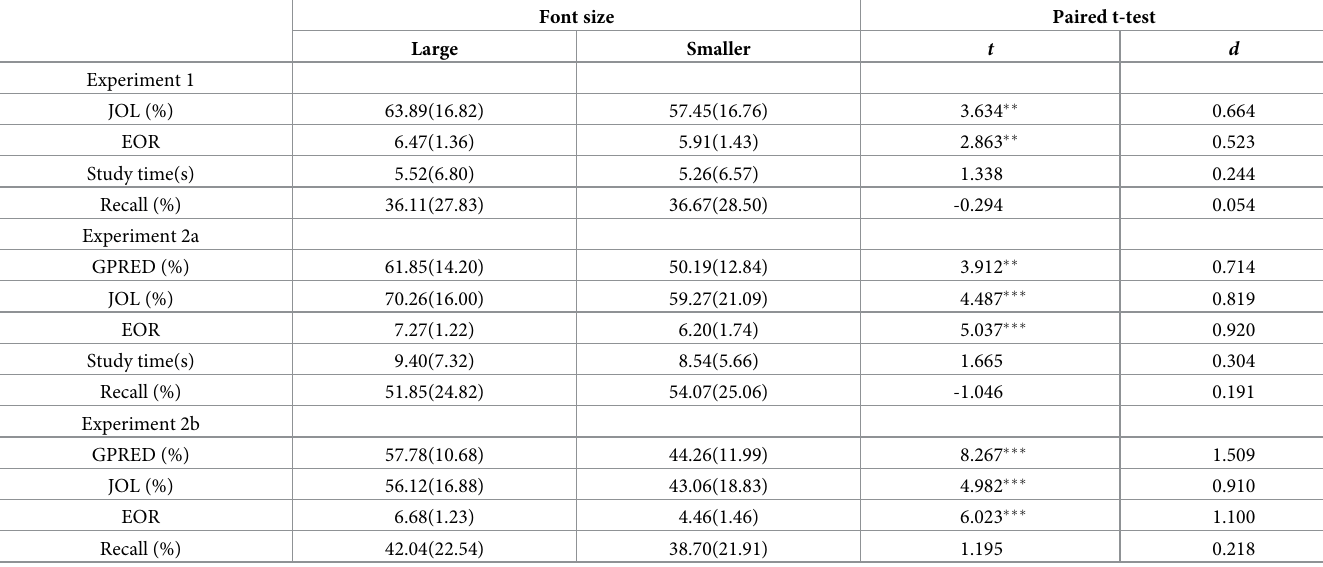
Table 2. Basic descriptive statistics for Experiments 1, 2a and 2b.